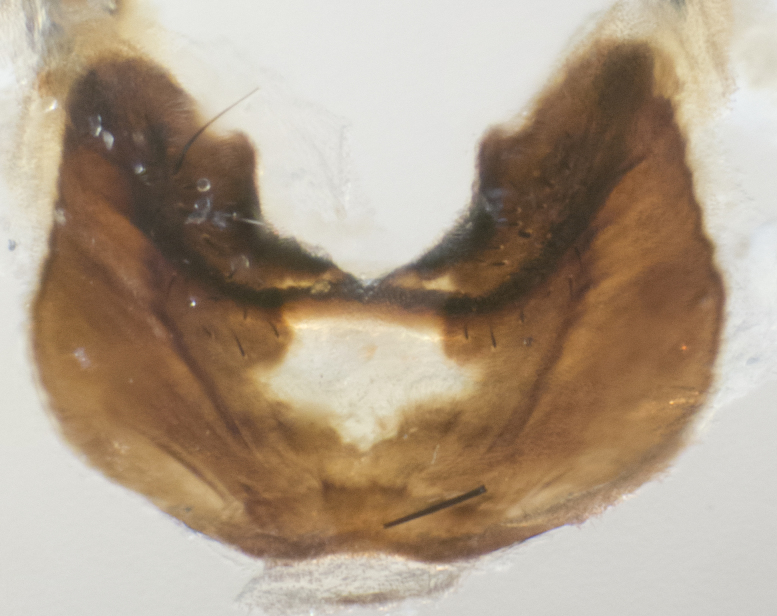
sternite 5, ventral view